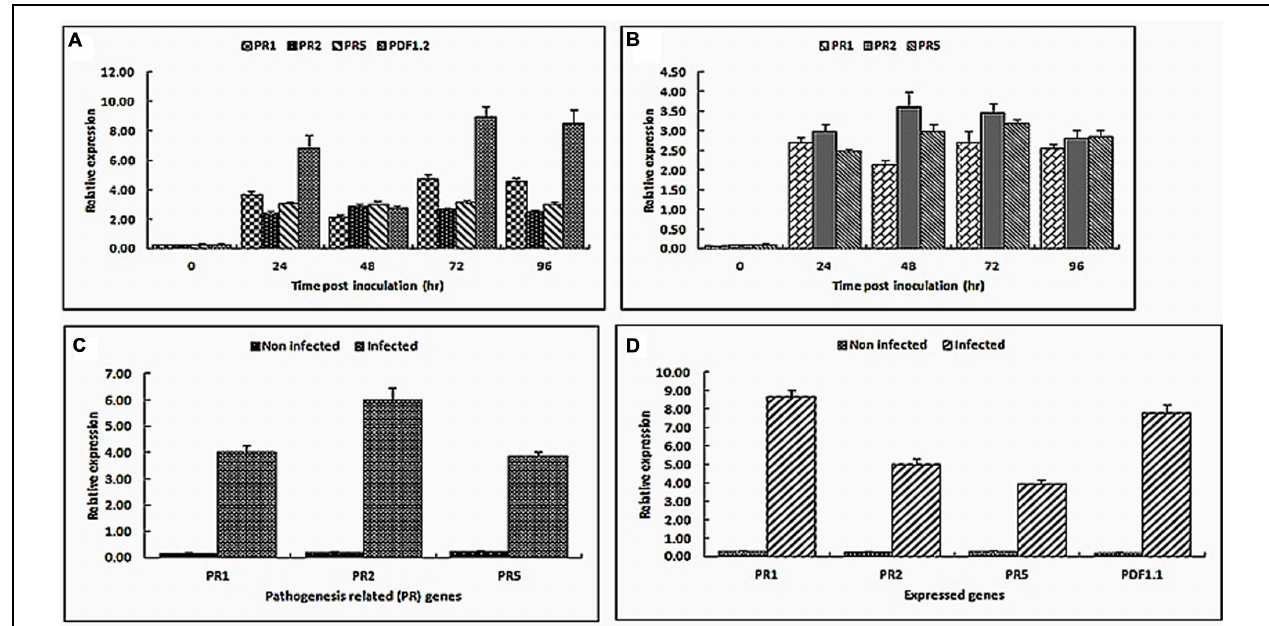
FIGURE 6 | Real-time RT-PCR analysis of PR1, PR2, PR5, PDF1.1, and PDF1.2 gene expression in Arabidopsis leaves (A), roots (B), flowers (C), and pods (D) upon a treatment with U. virens . Arabidopsis leaves and roots were inoculated by adding a suspension of germinated microconidia in order to reach the concentration of 5 × 10 5 conidia mL − 1 . Control leaves, flowers, roots, and pods were treated with sterile distilled water. Expression levels were normalized with respect to the housekeeping gene Actin . Data bars represent the mean ± SD of three repeats of the transcripts assessed at 0, 24, 48, 72, and 96 h post-inoculation for leaves and roots while flowers and pod gene transcripts were assessed 5 weeks post